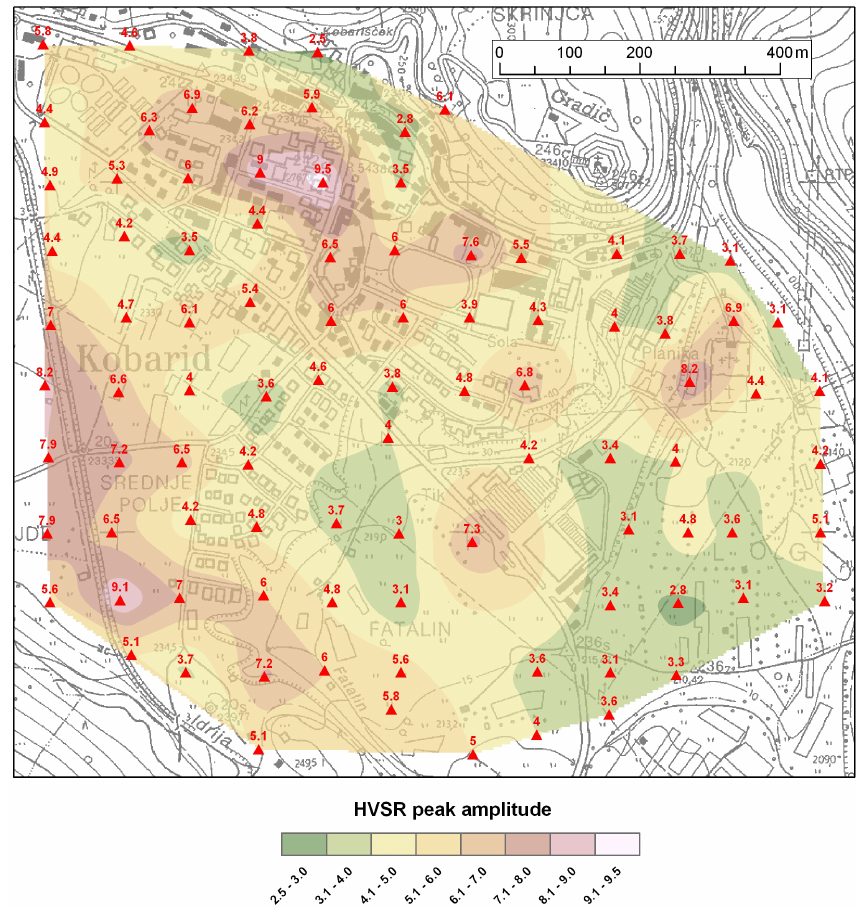
Fig. 7. Map of microtremor HVSR peak amplitudes. Red labels indicate peak amplitudes. Table 2. Main results of microtremor measurements inside buildings. Locations of buildings are shown in Fig. 6. Number of Longitudinal Transverse Free-field freq. Danger of